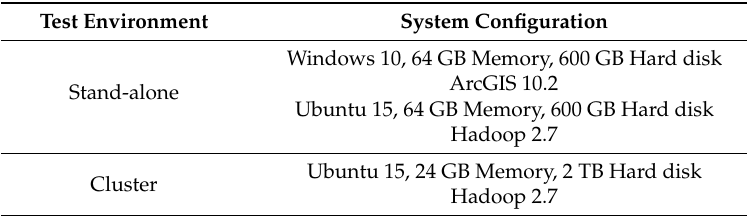
Table 1. The test environment for the data conversion algorithm.